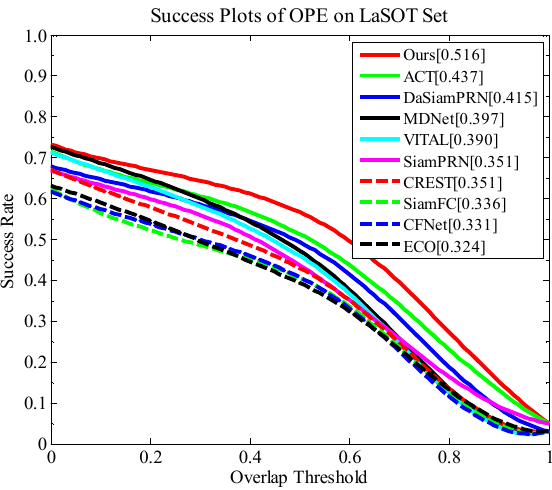
Figure 4. Success plot of OPE on LaSOT benchmark.